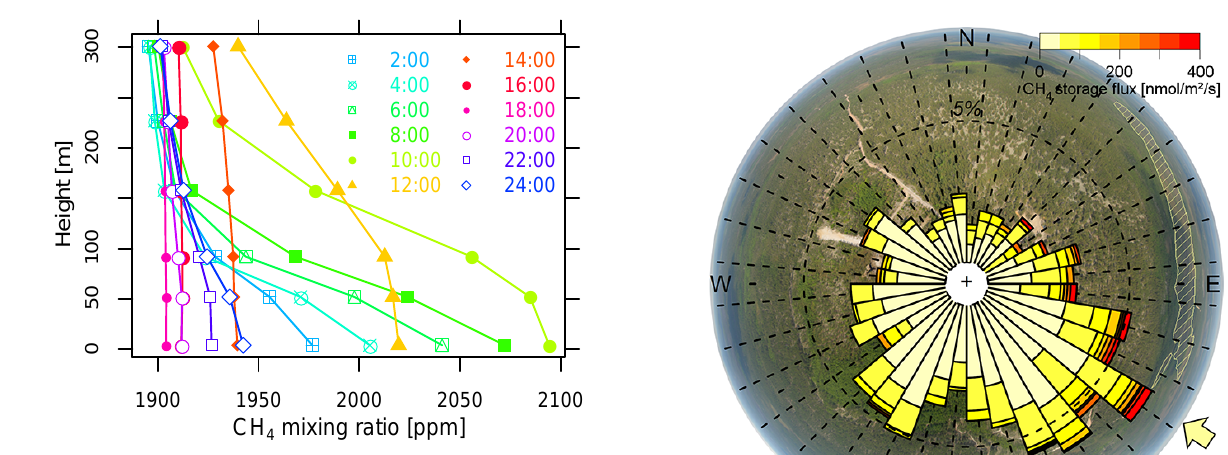
Fig. 10. Diurnal variation of the CH 4 mixing ratio at ZOTTO tower in July 2009.